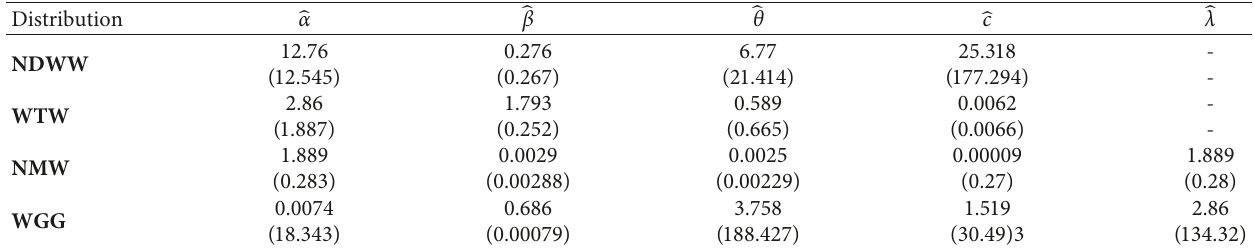
Table 10: MLEs and (SErs) for the dataset (3) COVID-19.